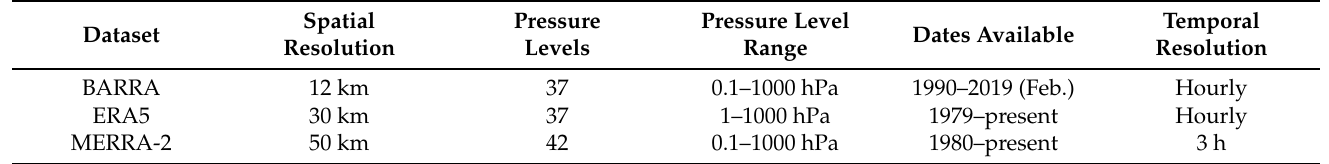
Dates Available